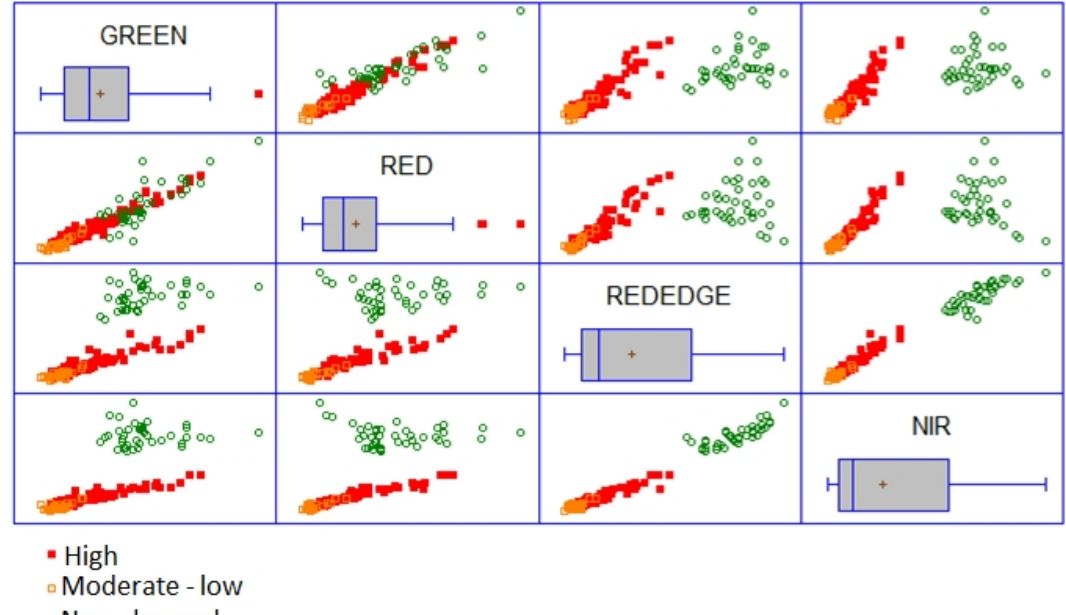
Figure 4. Matrix plot including the scatterplots among the four Parrot Sequoia spectral bands taking into account the different burn severity levels (high, moderate-low and non-burned). Partial correlation coefficients between each pair of UAV spectral bands are shown in Table 1.